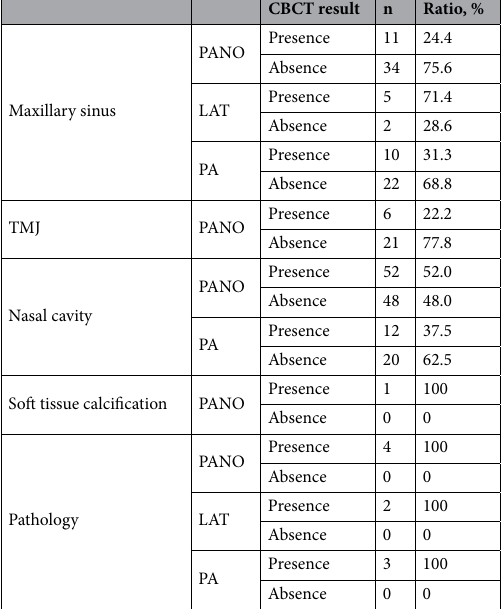
Assumption 1: “Not determined” as